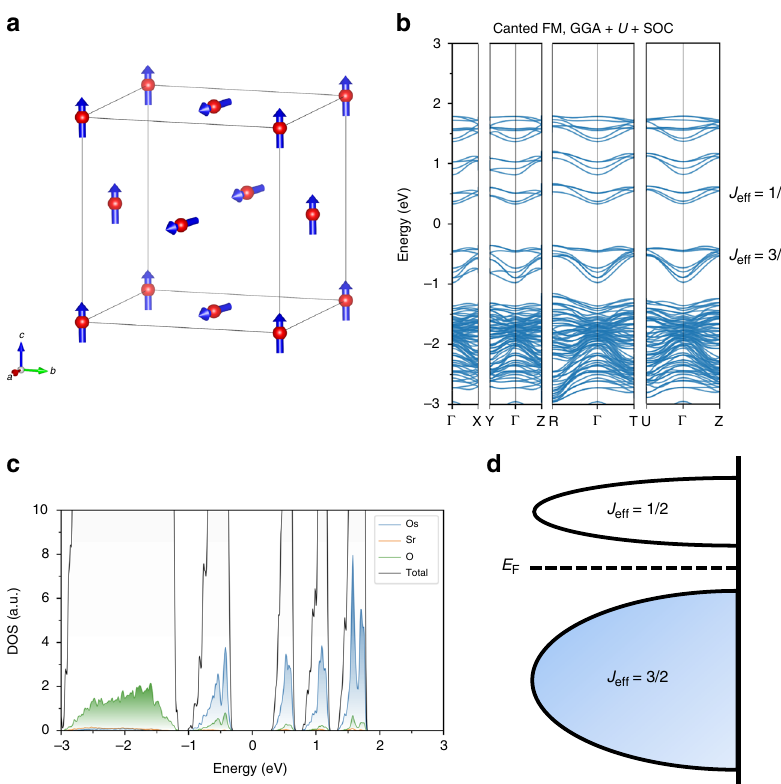
Fig. 4 Electronic-structure calculations with the PBE functional. a Schematic diagram of the magnetic ground state (canted FM order) of Sr 3 OsO 6 obtained from the DFT calculation. In a , red spheres and blue arrows indicate Os atoms and magnetic moments of Os atoms, respectively, and the Sr and O atoms are omitted for simplicity. b The band structures for Sr 3 OsO 6 with the canted FM order calculated by GGA + U + SOC. c The element-speci fi c partial density-of-state (PDOS) for the canted FM order calculated by GGA + U + SOC. In c , blue, orange, and green curves indicate the density-of-states per one Os, Sr, and O atoms, respectively. In b and c , the origin of energy was taken at the center of the bandgap. d Schematic energy diagrams for the Os 5 d 2 con fi gurations. In d , only PDOS for Os is taken into account and the contributions by Sr and O are omitted for sensor head is equipped with a fi lament, which generates thermal electrons for the excitation of Sr and Os atoms. Optical band-pass fi lters are used for element- speci fi c detection of the excited optical signals, since the emitted light spectra are characteristic for Sr and Os. The EIES sensor is equipped with photomultipliers (PMTs) located outside of the vacuum chamber that convert optical signals into electrical signals. The Sr and Os fl uxes measured by EIES were kept constant (Supplementary Fig. 1b) by the proportional-integral-derivative (PID) control of the evaporation source power supply. We optimized the fl ux ratio of Sr and Os to ascertain Sr 3 OsO 6 fi lms with a high saturation magnetic moment. Supplementary Fig. 2 shows the in-plane M – H curves at 300K for Sr 3 OsO 6 fi lms grown with different fl ux ratios of Sr and Os. The saturation magnetic moment of the fi lm grown with the fl ux ratio of Sr:Os = 2.05:1 is ten or more times larger than those for the fi lms grown with the fl ux ratio of Sr:Os = 2.05:1.02 and 2.05:0.98. This means that the magnetic properties of Sr 3 OsO 6 fi lms are very sensitive to the Sr/Os ratio and that well-controlled Sr and Os fl uxes during the growth are important for the high saturation magnetic moment. Therefore, in this study, we set the fl ux ratio of Sr:Os at 2.05:1. The cubic crystal structure of Sr 3 OsO 6 is illustrated in Supplementary Fig. 3a. Supplementary Fig. 3b,c show re fl ection high-energy electron diffraction (RHEED) patterns of a Sr 3 OsO 6 thin fi lm surface, where the sharp streaky patterns with clear surface reconstruction indicate the growth of the Sr 3 OsO 6 fi lm in a layer-by-layer manner, leading to the high crystalline quality of the fi lm. Notably, [01 l ] diffractions are not seen (Supplementary Fig. 3b) due to extinction rules, indicating the formation of a cubic B-site ordered double-perovskite 8,12,20 . The cubic structure model is further supported by high-resolution X-ray reciprocal space mapping (HRRSM) (Supplementary Fig. 3d): the in-plane and out-of-plane lattice constants of Sr 3 OsO 6 are identical within the resolution limits (8.24 ± 0.03 and 8.22 ± 0.03Å, respectively). It is therefore reasonable that the Sr 3 OsO 6 fi lms are epitaxially but not coherently grown on the SrTiO 3 (3.905 Å) substrate. Transmission electron microscopy and transmission electron diffraction . High-angle annular dark- fi eld (HAADF), annular bright- fi eld (ABF) scanning transmission electron microscopy (STEM) images, and transmission electron dif- fraction (TED) patterns were taken with a JEOL JEM-ARM 200F microscope.